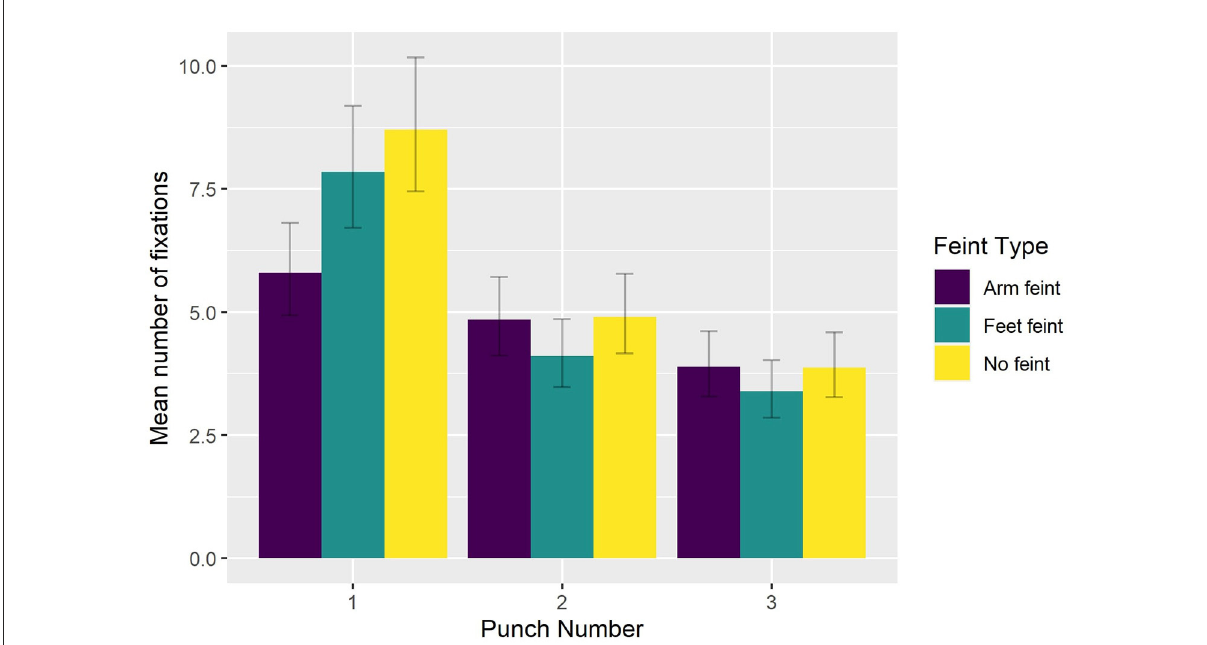
FIGURE5 Group mean number of fixations as a function of Feint Type and Punch Number.